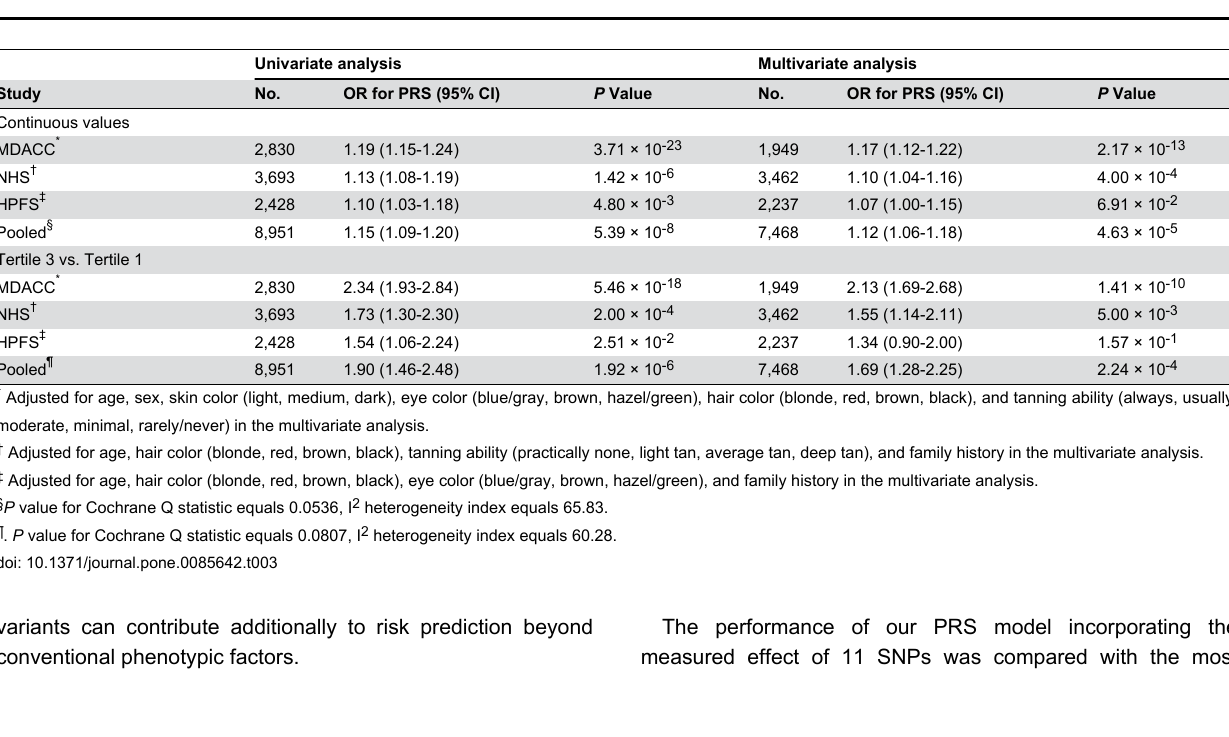
Minor allele SNP